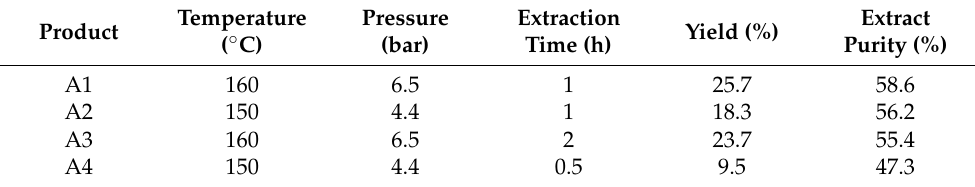
Table 2. Yield and extract purity of different hydrothermal procedures at